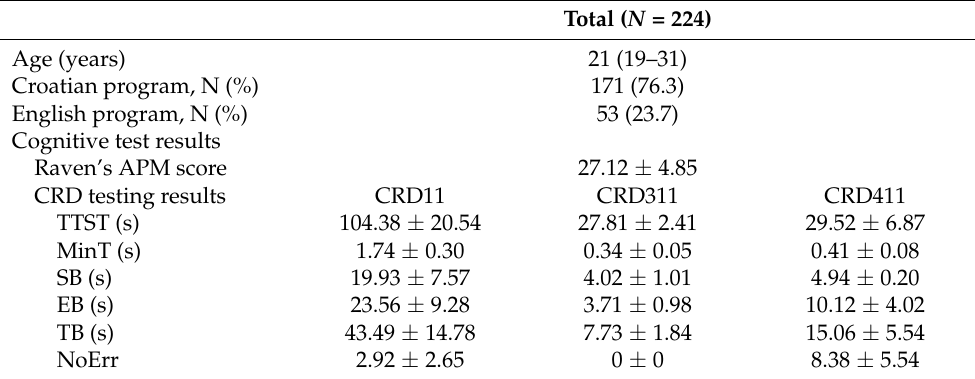
Table 1. Demographic characteristics and performance of the Raven’s APM and CRD-series of study